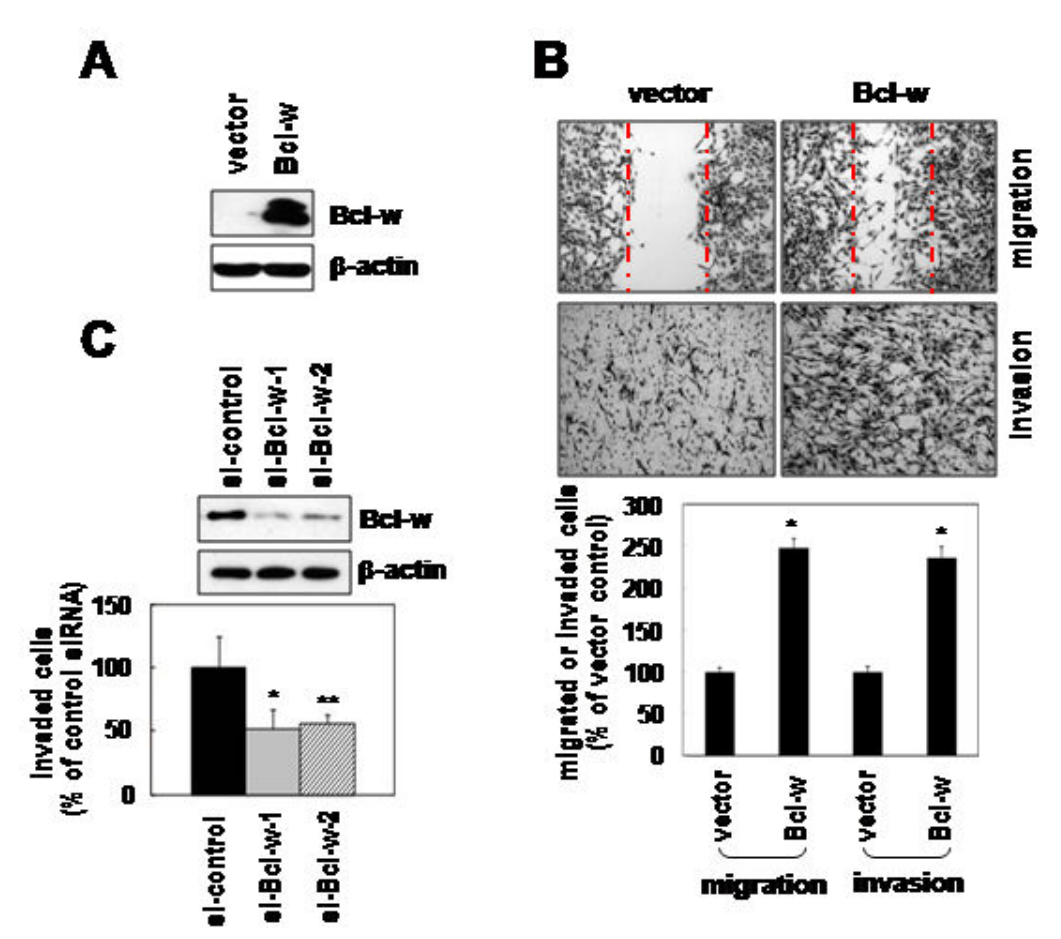
Figure 3. Bcl-w enhances migration and invasion in U251 glioblastoma cells. A , either empty pcDNA vector or that containing Bcl-w cDNA introduced into U251 cells. Bcl-w expression was detected using Western blotting. B , Bcl-w promotes migration and invasiveness of U251 glioblastoma cells. Top, the confluent cells in five fields from the scratched area (200 x 500 µm 2 ) were counted under a light microscope. Transfectants were seeded onto Matrigel-coated polycarbonate filters to analyze their invasive potential. Cells were incubated for 20 hours in modified Boyden chambers, and the number of cells invading through filters stained and counted under a light microscope. Bottom, mean of triplicate experiments significantly different from controls. *, p< 0.05. C , two different siRNA sequences targeting Bcl-w (20nM of si-Bcl-w-1 and si-Bcl-w-2) were introduced into U251 cells for 24 hours, and the invasion assay conducted after 24 hours of incubation. Experiments were repeated five times, and the mean values and standard deviations determined. *, p< 0.05; **, p < 0.005.